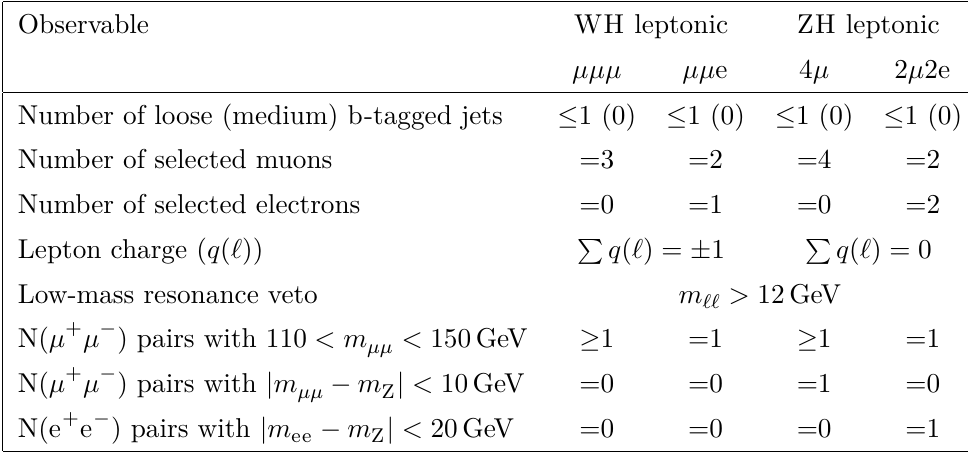
Table 7 . Summary of the kinematic selection used to define the WH and ZH production